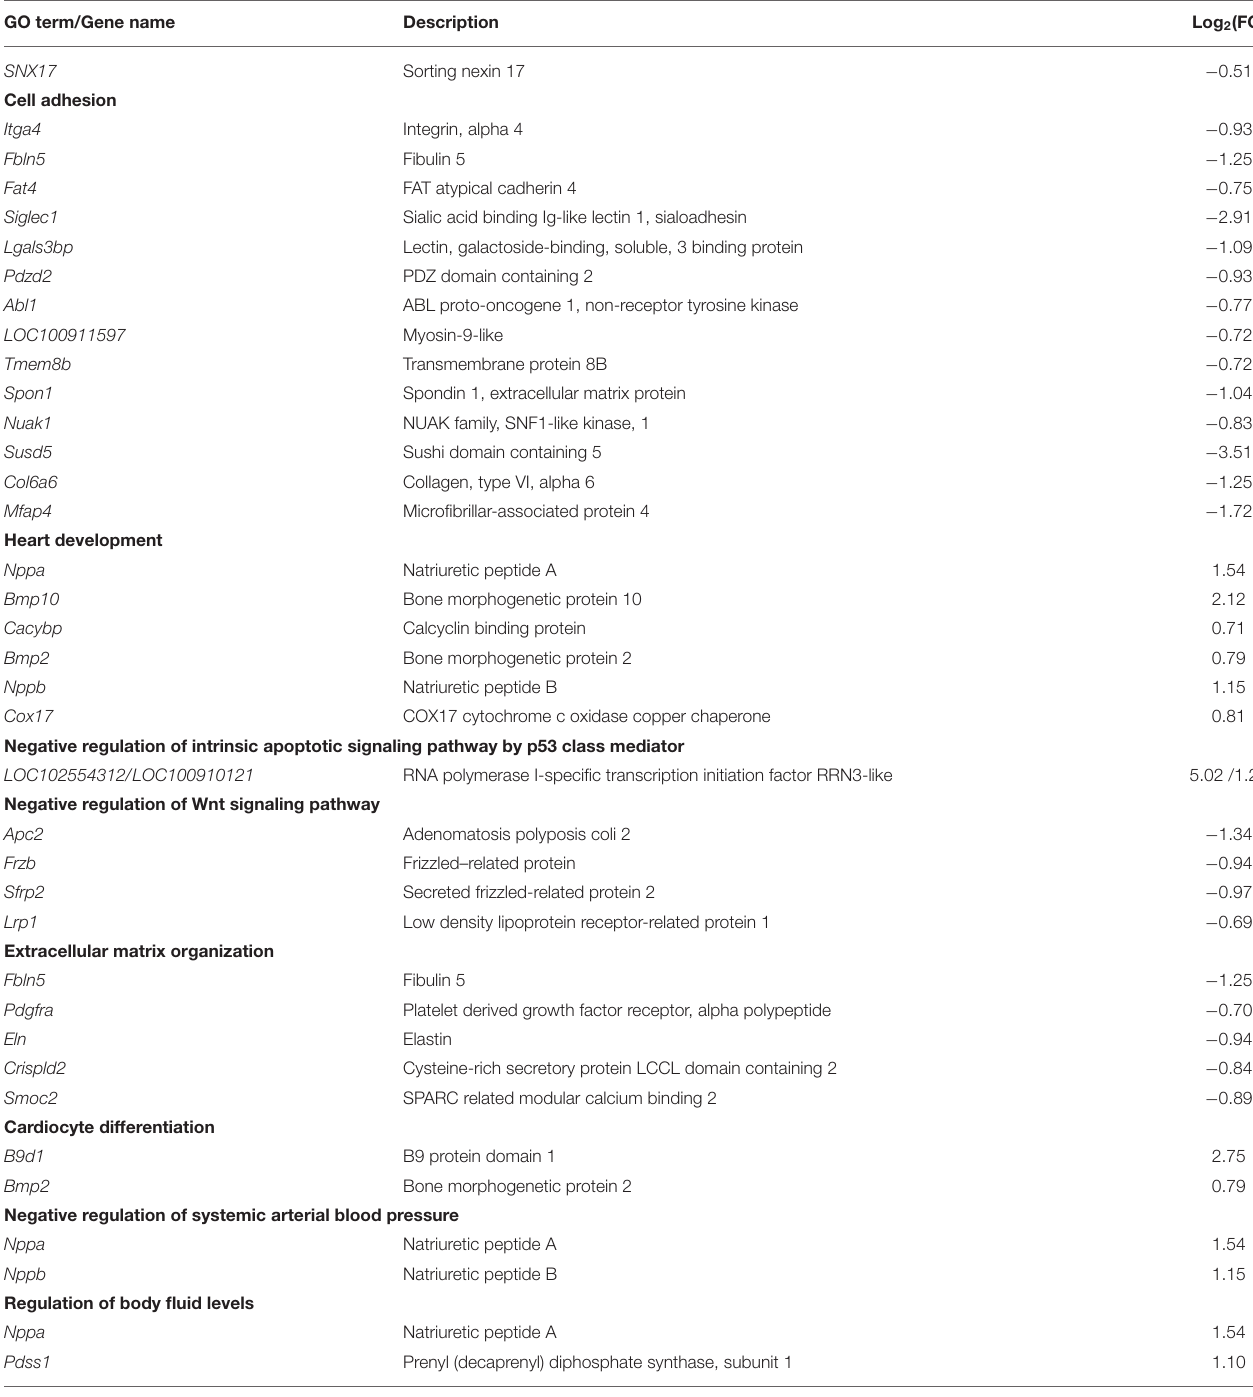
TABLE 2 | Functional categorization of DEGs in biological process, relating to OFT